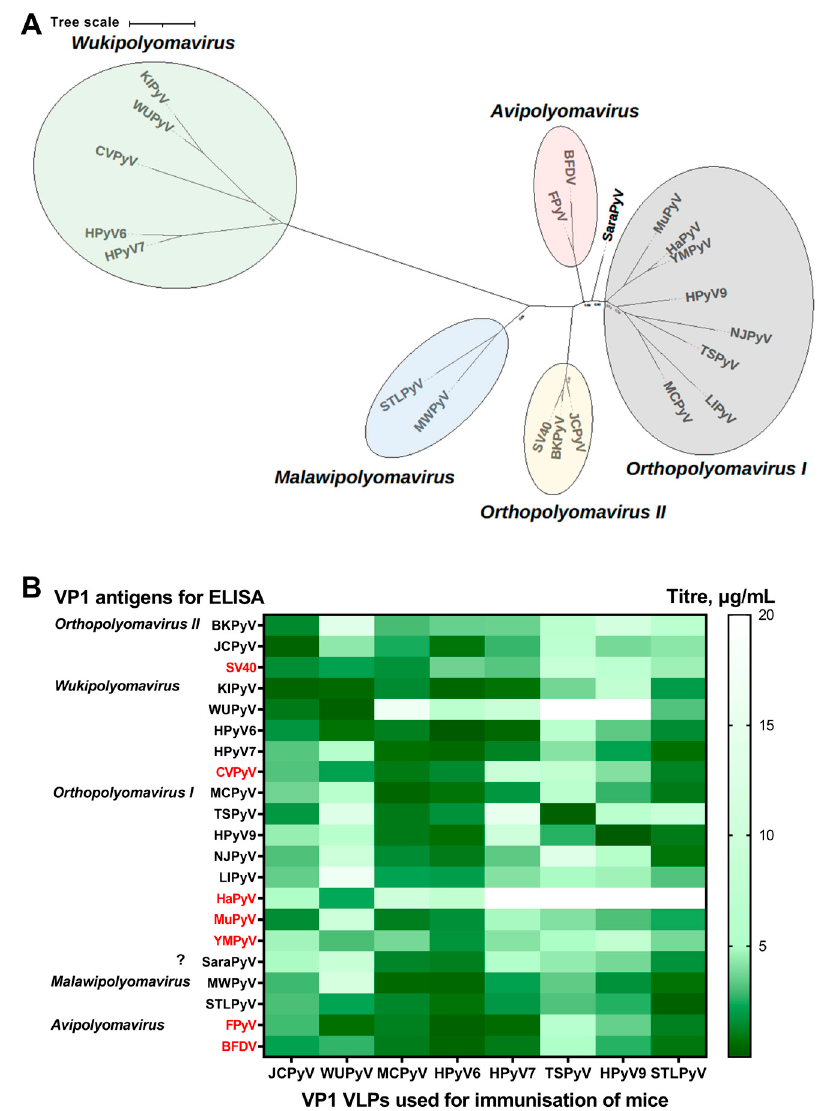
Figure 3. Cross-reactivity of mouse antisera with VP1 proteins of different PyVs. ( A ). Unrooted maximum likelihood phylogenetic tree of PyVs based on VP1 amino acid sequences. Five distinct phylogenetic groups: Wukipolyomaviru s, Avipolyomavirus , Orthopolyomavirus I and II , and Malawipoly- omavirus, are marked in different colors. Transfer bootstrap expectation values lower than 0.9 are shown. ( B ). Antisera raised against VP1-derived VLPs of different HPyVs were tested with different VP1 VLPs of mammalian, including human, and avian PyVs by an indirect ELISA. The diluent buffer was used as a negative control. The X axis presents the antigens used for immunization of mice, while the Y axis shows antigens used for the coating of ELISA plates. On the left panel, PyVs are grouped according to similarities of their VP1 protein sequence. Non-human PyVs are highlighted in red. The smaller values of titres in the heat map mean a stronger antibody reactivity. The values of titres ( µ g/mL) in the heat map equal to 20 are assumed as showing no cross-reactivity according to the negative control; 5–15—moderate reactivity; 1–5—strong reactivity; <1—very strong reactivity. Titration curves are shown in Figure S2.